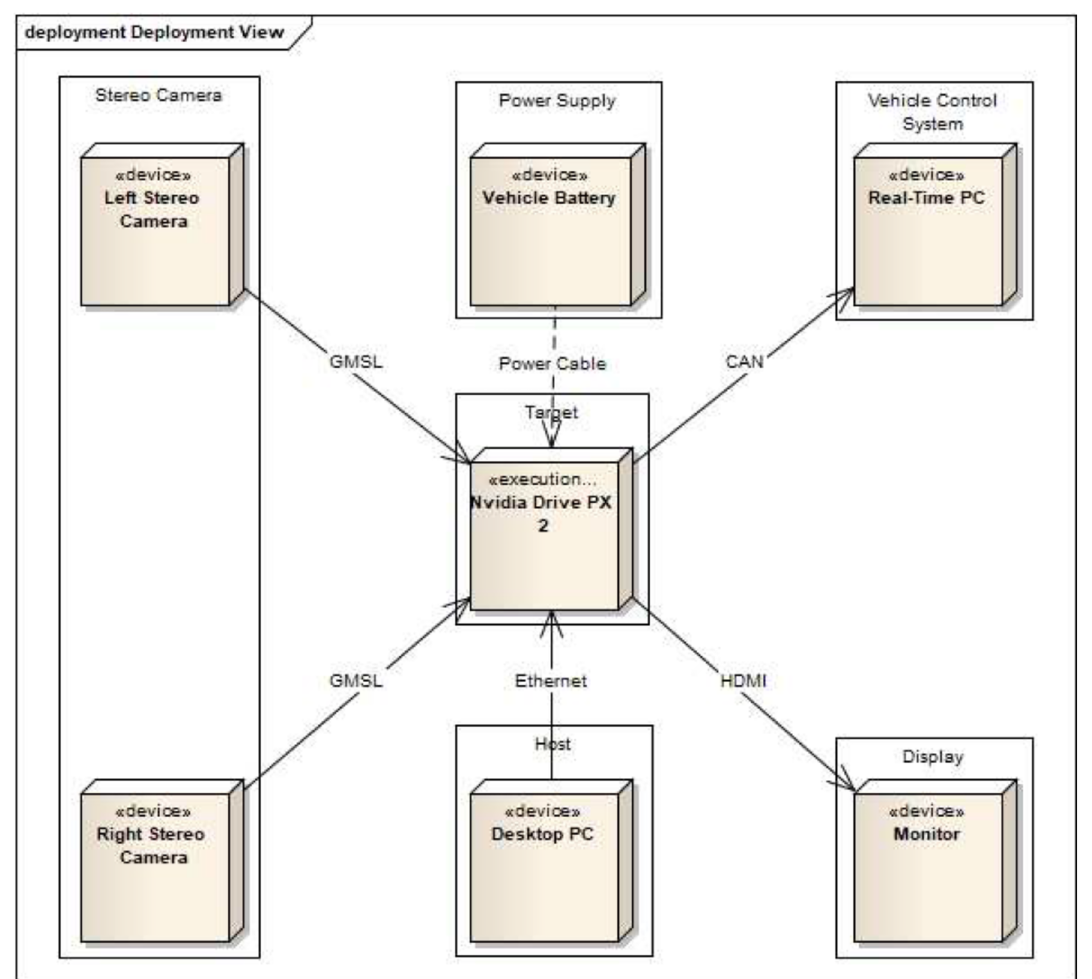
Fig. 11 Deployment diagram of the stereo vision